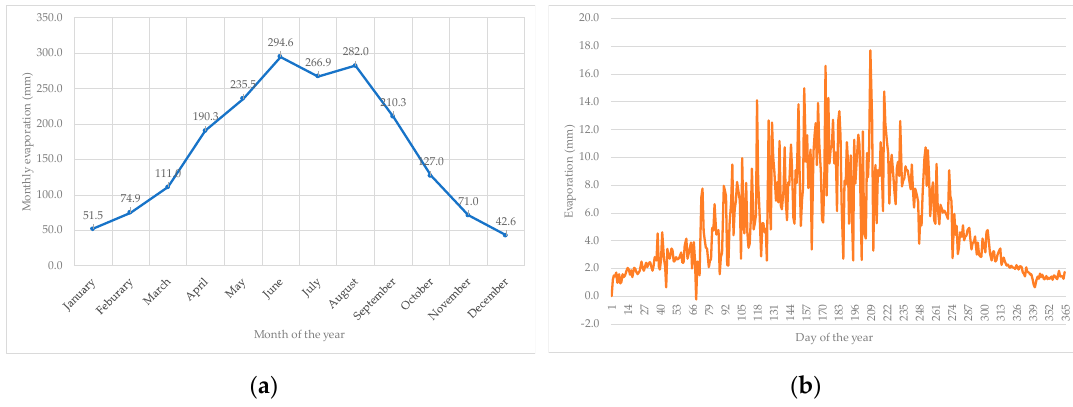
Figure 4. Water evaporation simulation results for Lake Mead: ( a ) simulated evaporation values (mm) for each month of the year 2018; ( b ) simulated evaporation values (mm) for each day of the year 2018.